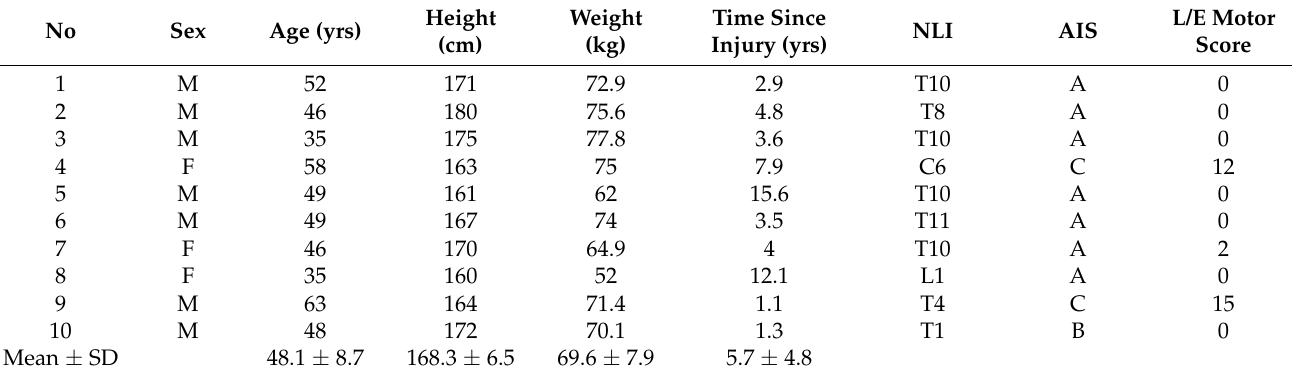
Table 1. Demographic and clinical characteristics of the